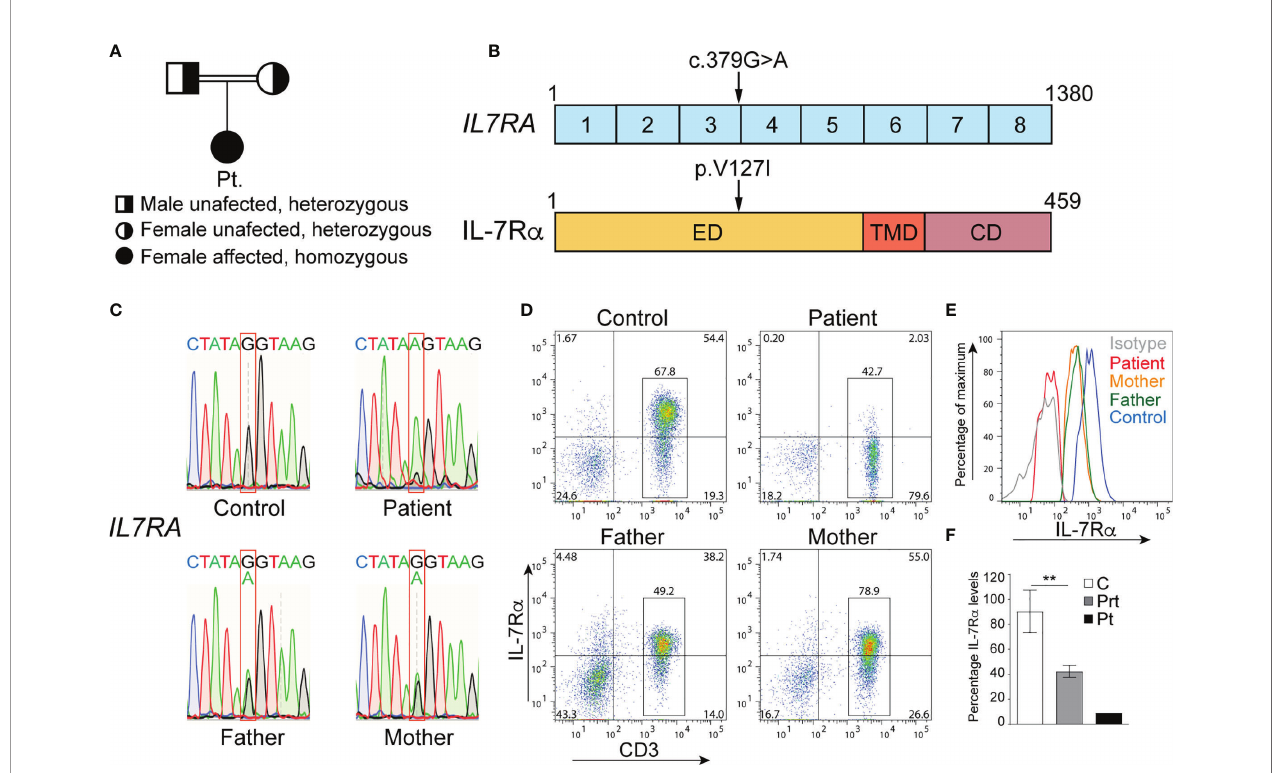
FIGURE 2 | Mutation in IL7RA that abolishes surface protein expression. (A) Family pedigree. (B) cDNA organization of IL7RA and IL-7R a protein structure showing the domains and location of the patient ’ s mutation indicated by the arrows. Boxes represent exons or protein domains. (C) Sanger sequencing chromatograms depicting the c.379G>A homozygous mutation in IL7RA in the patient and the heterozygous mutation in her parents, as compared to the reference sequence in the control. (D, E) Representative dot plot (D) and histogram (E) analysis of IL-7R a cell surface expression on CD3 + T cells from the patient and her parents, as compared to a control. (F) Columns and bars represent the mean ± SEM of the levels of IL-7R a expression (MFI), with the healthy controls set at 100%. N = 5 controls, the pooled parents done in 2 independent experiments, and the patient done once. **p < 0.001. ED, extracellular domain; TMD, transmembrane domain; CD, cytoplasmic domain; C, control; Prt, parent; Pt,